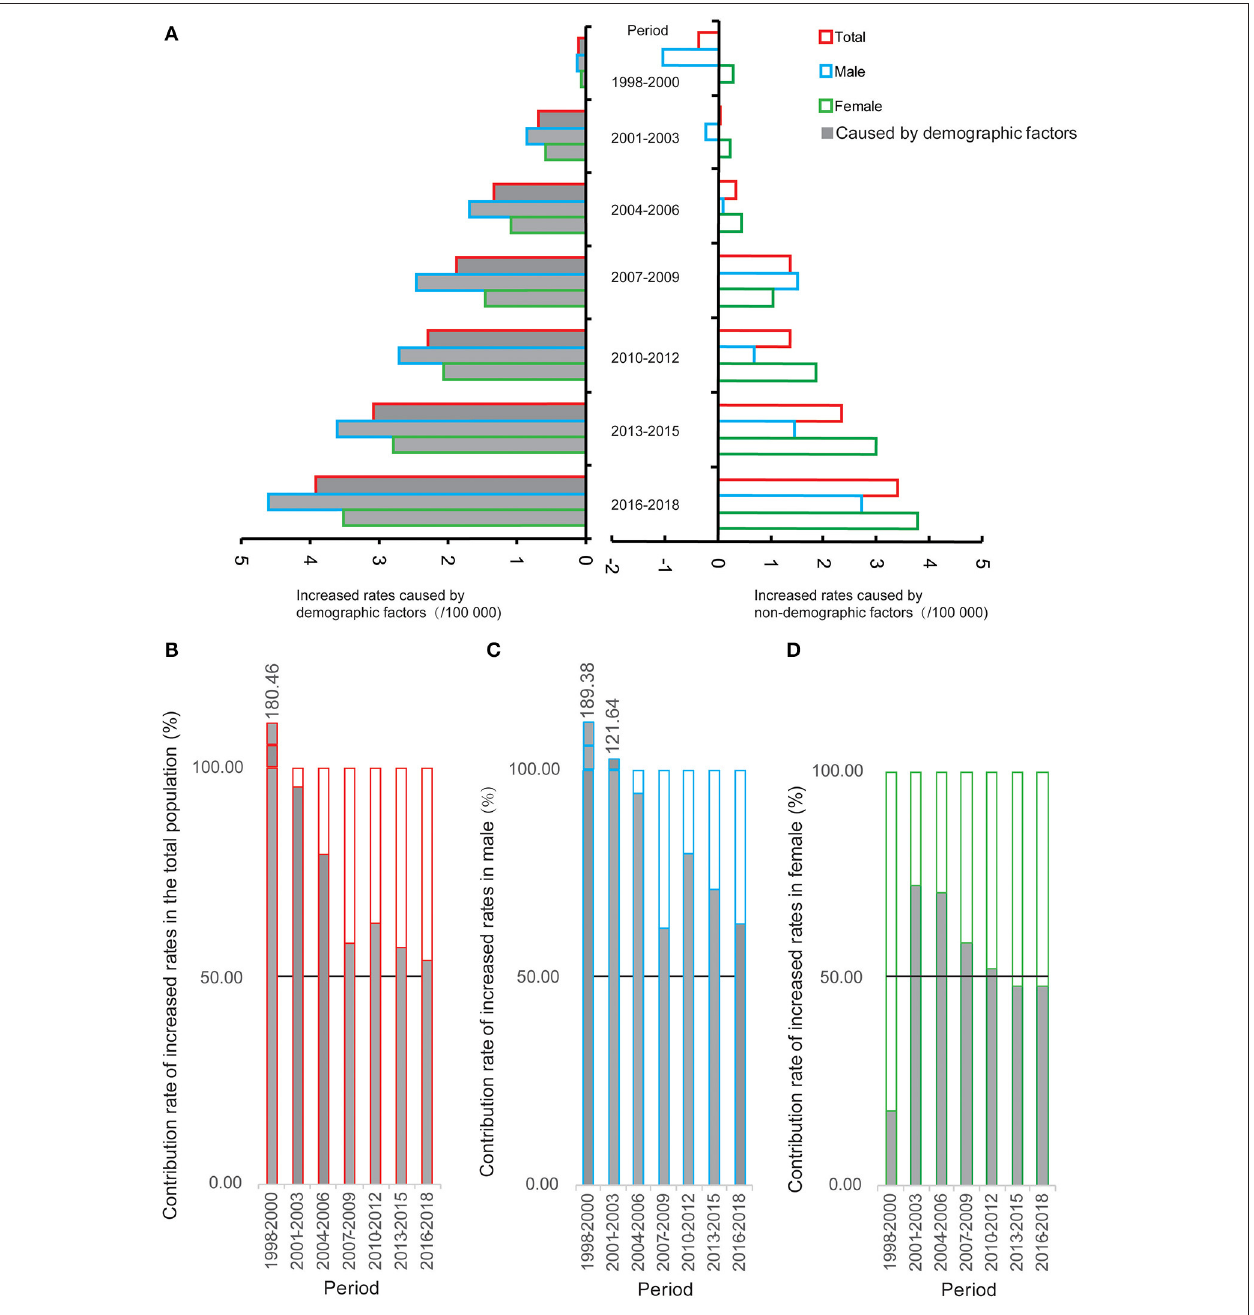
FIGURE 2 | The increased rates related to demographic and non-demographic factors and their proportion during the period from 1998 to 2018 compared with the crude mortality rate of selected neurological disorders during 1995–1997 in Pudong New Area, Shanghai, China. (A) The increased rates; (B) the contribution rate of increased rates in the total population; (C) the contribution rate of increased rates in males; (D) the contribution rate of increased rates in